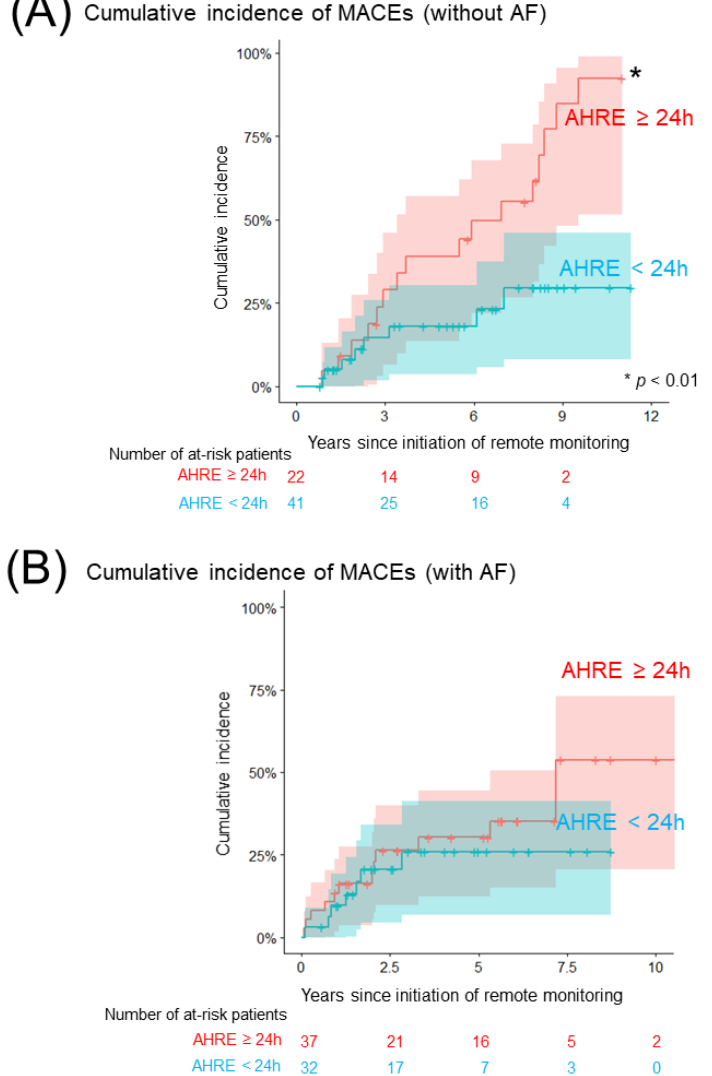
Figure 2. Comparison of the cumulative incidence of MACEs. ( A ) The Kaplan–Meier curve shows the cumulative incidence and 95% CI of MACEs following the initiation of remote monitoring among patients without a history of AF (red: patients with AHRE ≥ 24 h, blue: <24 h). ( B ) The Kaplan–Meier curve shows the cumulative incidence and 95% CI of MACEs following the initiation of remote monitoring among patients with a history of AF (red: patients with AHRE ≥ 24 h, blue: <24 h). The asterisk indicates statistical significance (* p < 0.01). AF, atrial fibrillation; AHRE, atrial high-rate episode; CI, confidence interval; MACE, major adverse cardiovascular event.